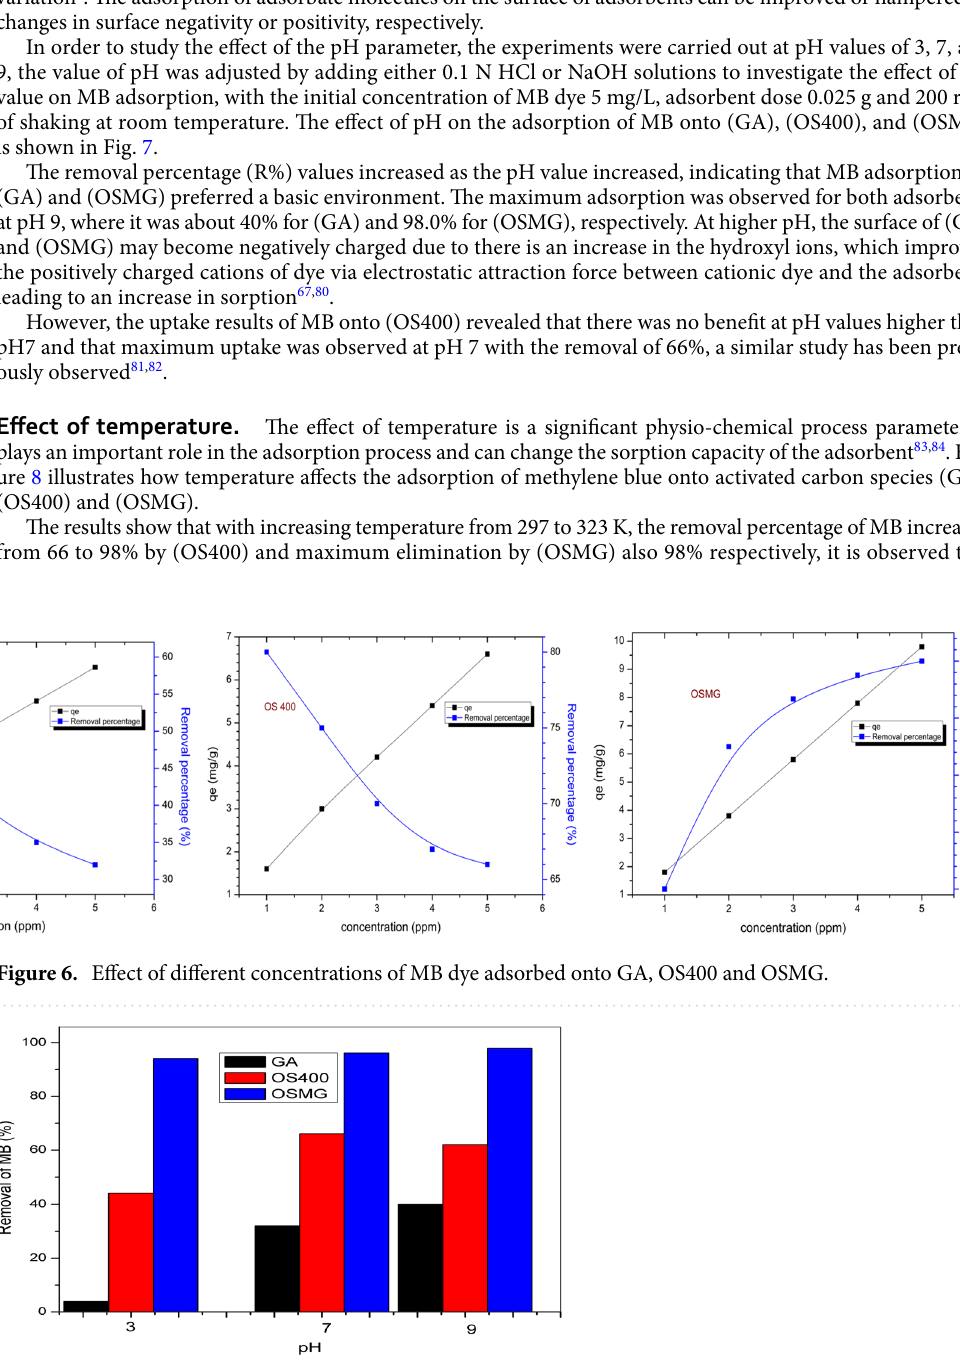
Figure 7. Effect of solution pH on the MB adsorption (adsorbent dose: 0.025 g. L −1 , dye concentration: 5 mg. L −1